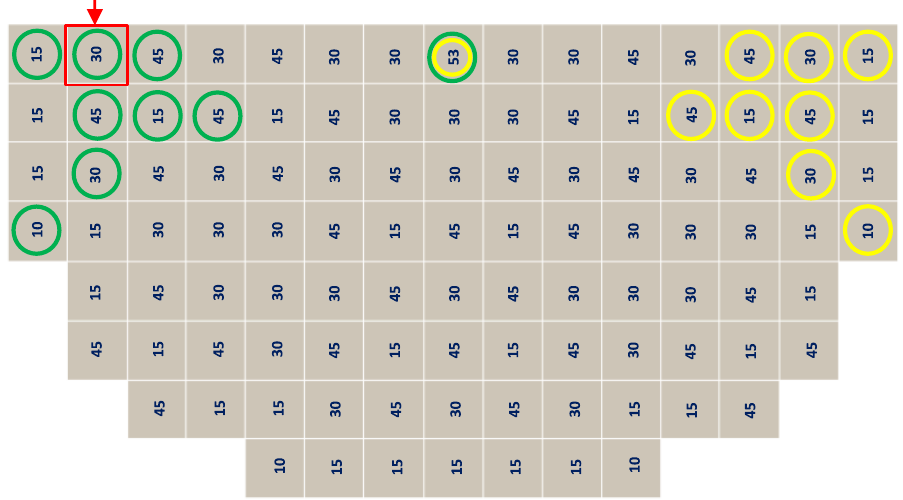
Fig. 8. Selected assemblies on the symmetric 1 / 2 PWR geometry for each cluster. The green circles indicate the selection of the mean and upper quantiles and the yellow circles indicates the selection for the lower quantile.